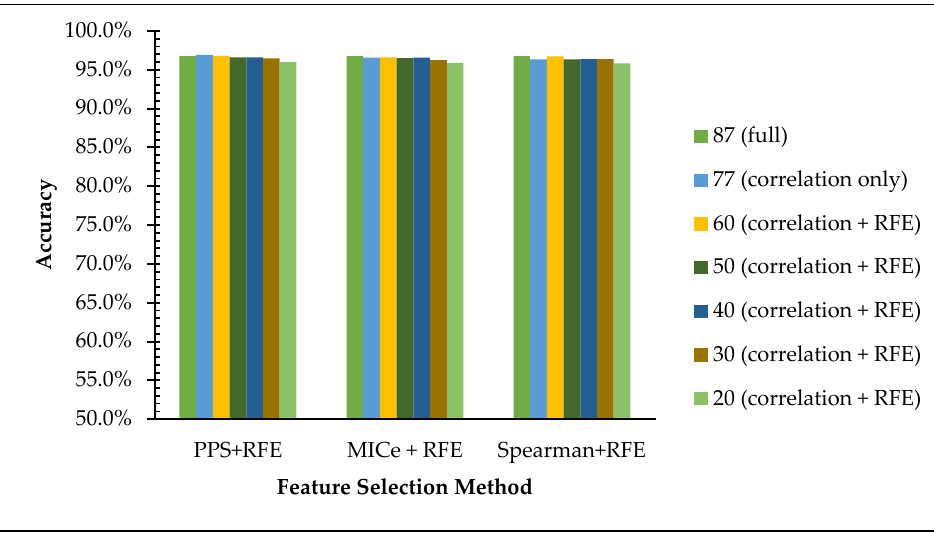
Figure 6. Comparison of all feature subset scenarios for dataset 2. Table 17. The studies feature set and accuracy comparison on Tan’s